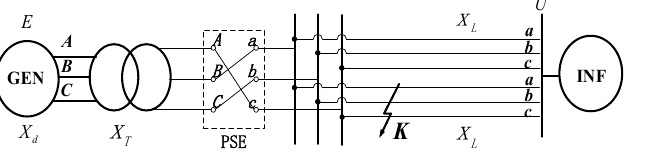
Figure 3. Single machine infinite system with phase sequence exchanging equipment.